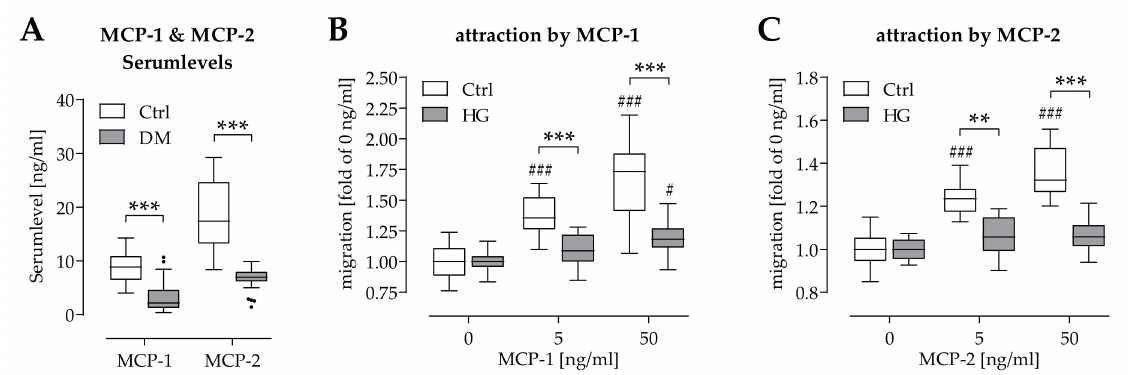
Figure 4. Attraction of THP-1 cells by MCP-1 and MCP-2 is impaired by pre-/diabetic conditions. ( A ) Levels of MCP-1 and MCP-2 in serum of newly diagnosed type 2 diabetics (N = 34) and respective controls (N = 32) were determined by ELISA. ( B ) Migration of THP-1 cells in the presence of MCP-1 or ( C ) MCP-2 under normoglycemic (Ctrl) and hyperglycemic (HG) conditions was determined with the help of Boyden chambers (N = 4 and n = 3). Data are presented as box plots. Data were compared by non-parametric 2-way ANOVA, followed by Sidak’s multiple comparison test. ** p < 0.01 and *** p < 0.0001 as indicated. # p < 0.05 and ### p < 0.0001 as compared to the respective control sample without